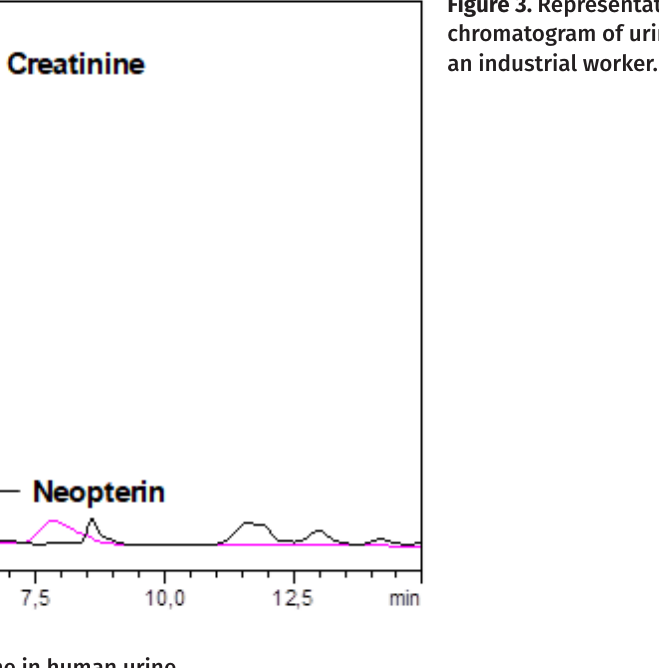
Table I. Linearity of neopterin and creatinine in human